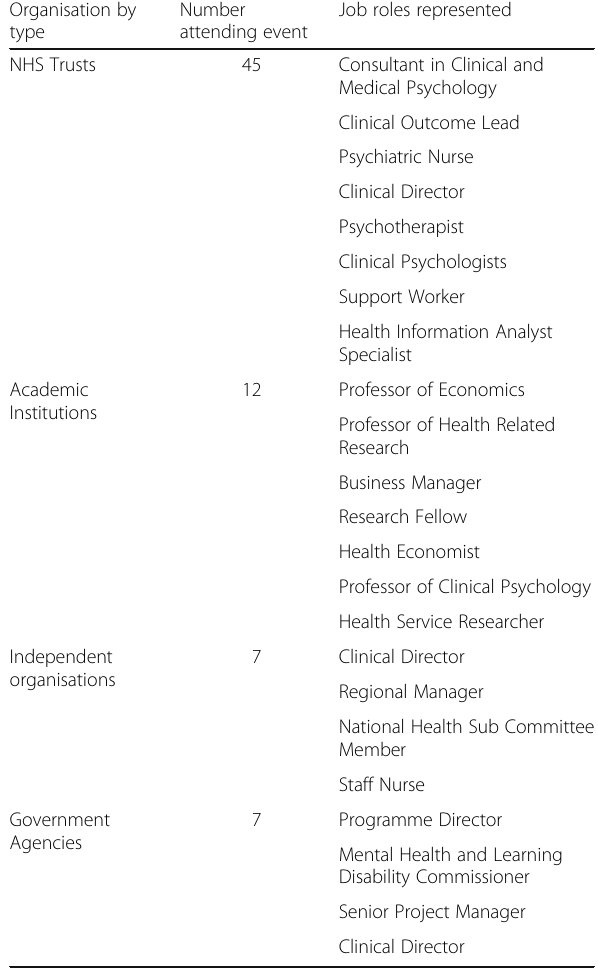
Table 1 Breakdown of people attending the event by organisation and job